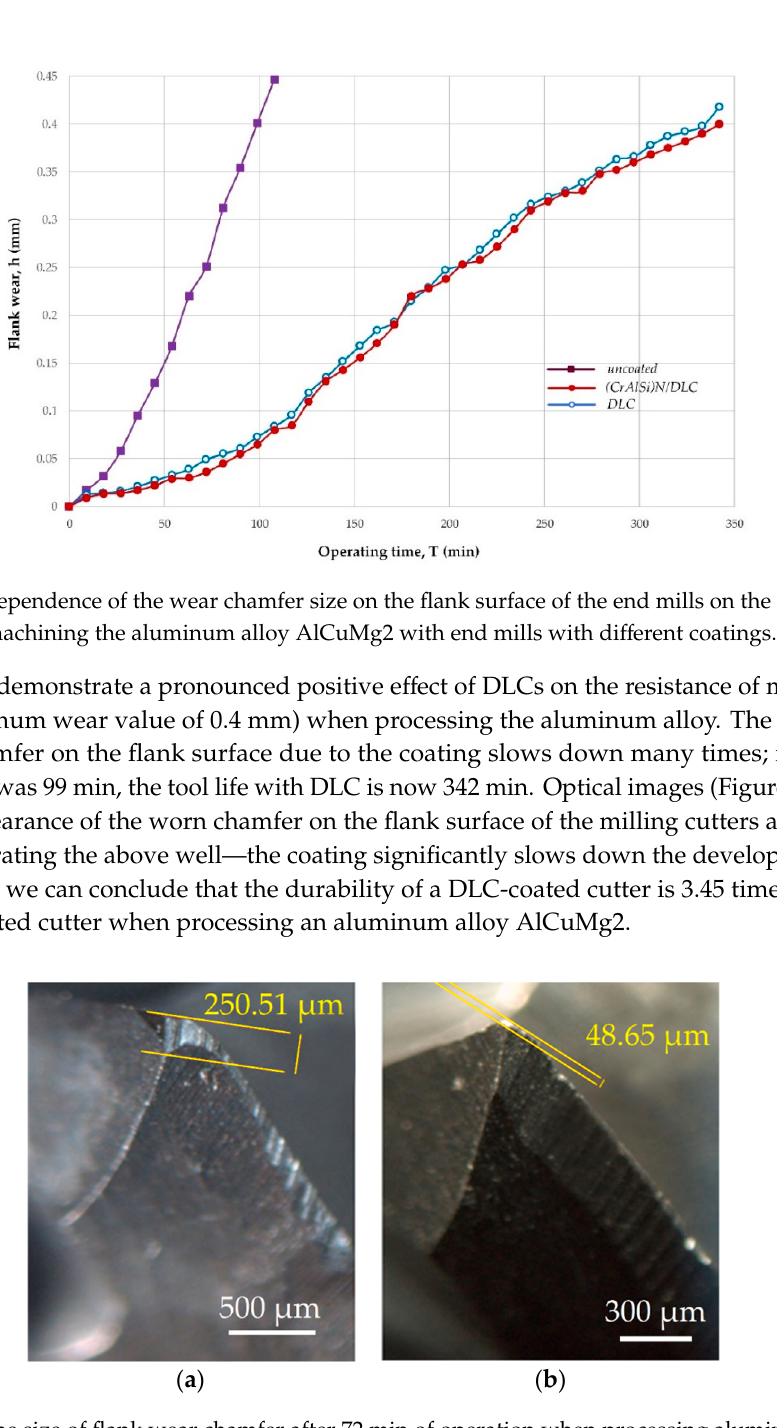
Figure 11. The size of flank wear chamfer after 72 min of operation when processing aluminum alloy AlCuMg2 with end mills: ( a ) uncoated, 250.51 μ m; and ( b ) with a single-layer DLC, 48.65 μ m.